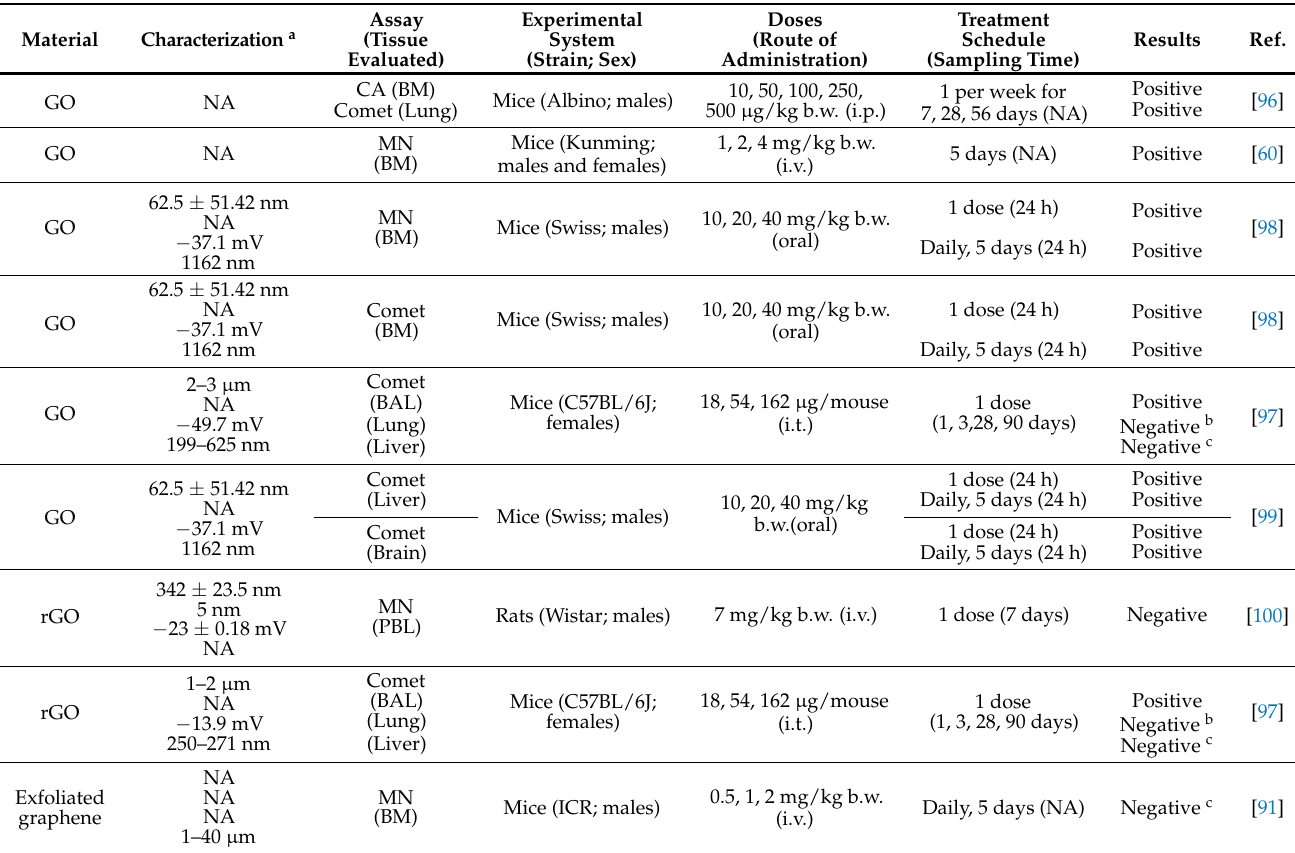
Table 7. In vivo studies assessing GBMs